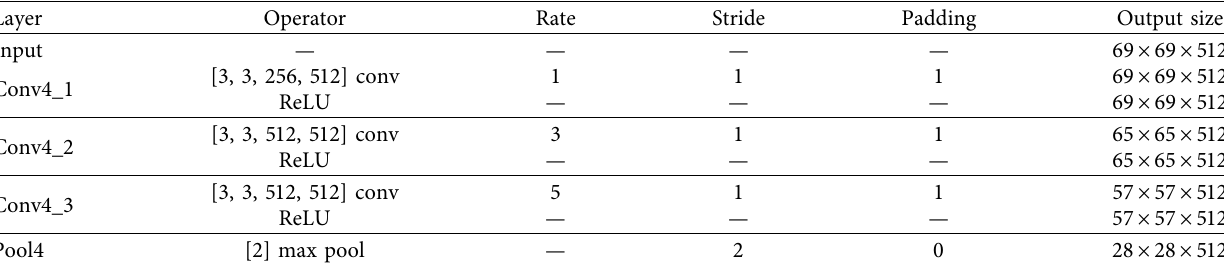
Figure 4: Convolutional combination of voids with expansion factor [1 2 9]. (a) Layer 2 convolution output feature map. (b) Layer 1 convolution output feature map. (c) Input feature map. Table 1: Parameters of convolutional module 4 in the new network.